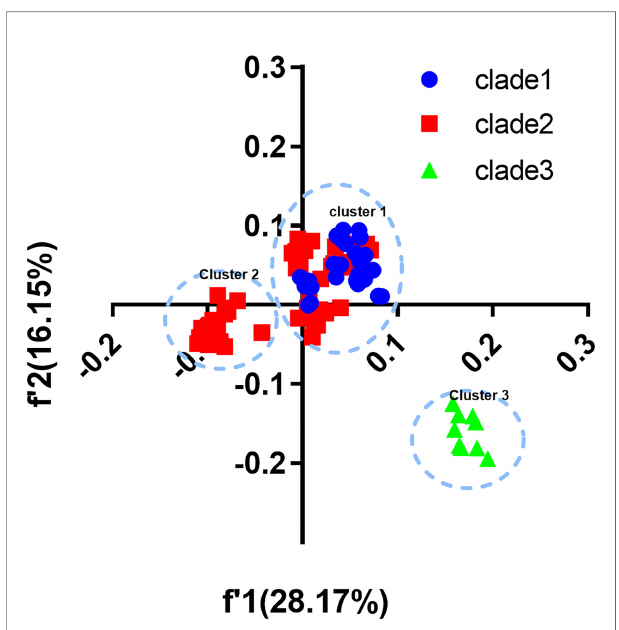
FIGURE 3 | Correspondence analysis (COA). COA plots were constructed for coding sequences of each EV-A